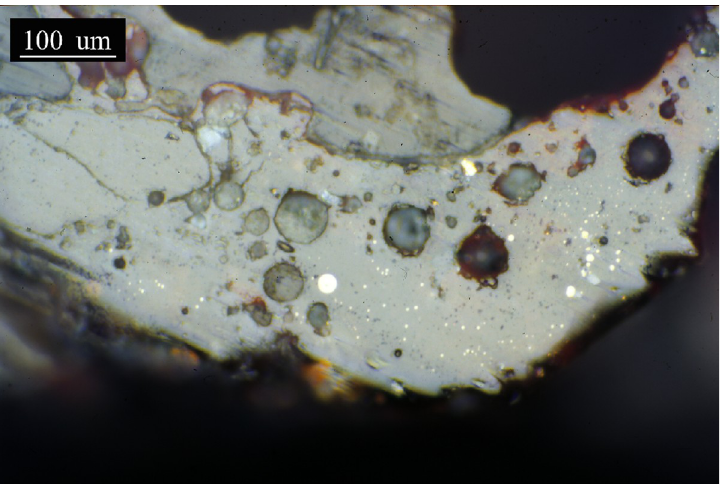
Fig 14. PPL micrograph of PA6326. Grey glassy matrix embedding numerous metallic prills. In the upper part of the image, large vacuoles can be seen resulting from the bloating of the ceramic. (Scale = 100 μ m).